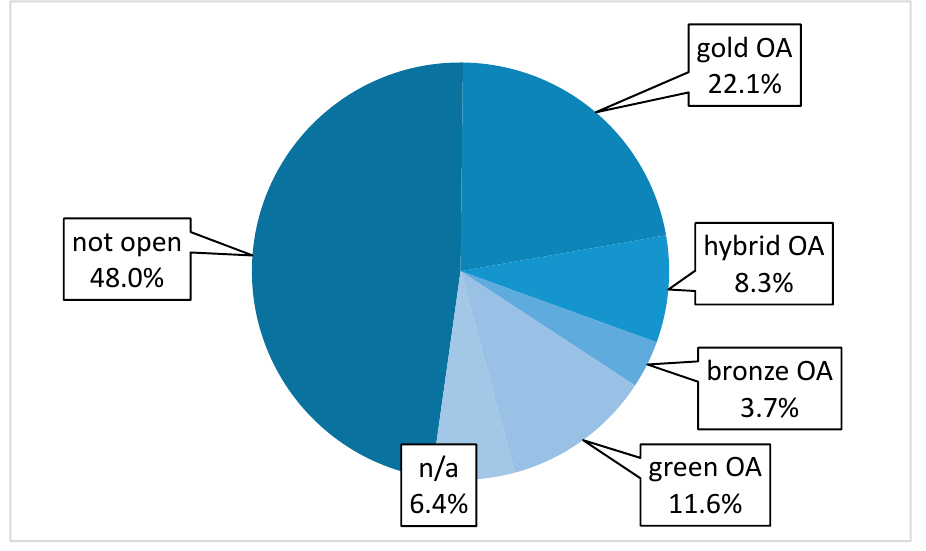
Figure 7. The part of open access ( n = 2489 articles).